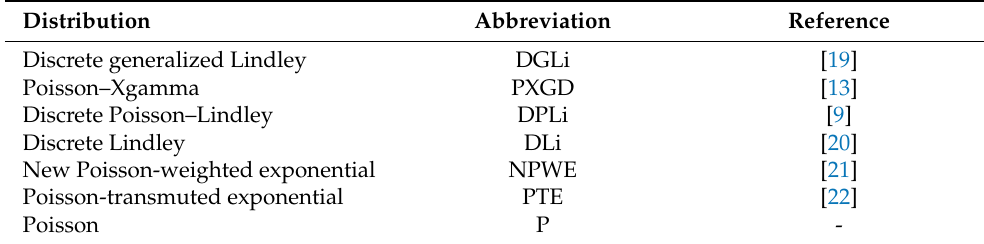
Table 4. The considered competitive